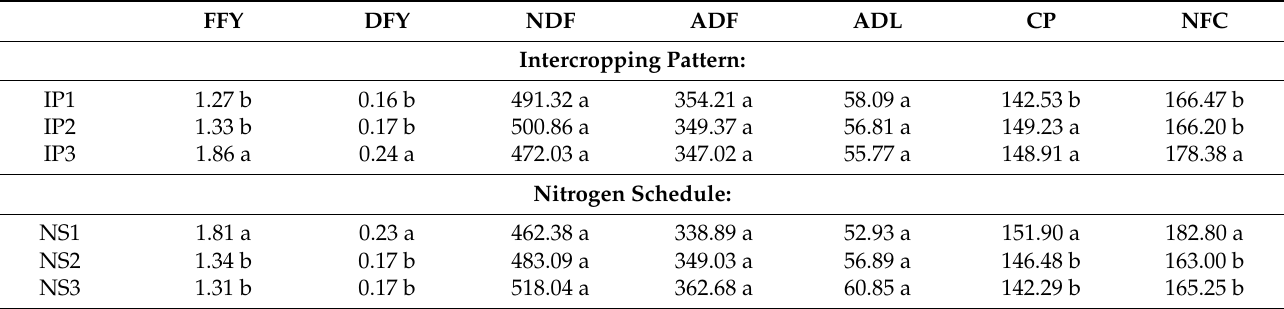
Table 7. Variations of the 3 rd cut fresh and dry forage yields (kg ha − 1 ), neutral detergent fiber (NDF), acid detergent fiber (ADF) and acid detergent lignin (ADL), crude protein (CP), and non-fiber carbohydrates (NFC) contents (g kg − 1 ) of forage cowpea as affected by the intercropping pattern and nitrogen schedule combined over the two growing seasons.